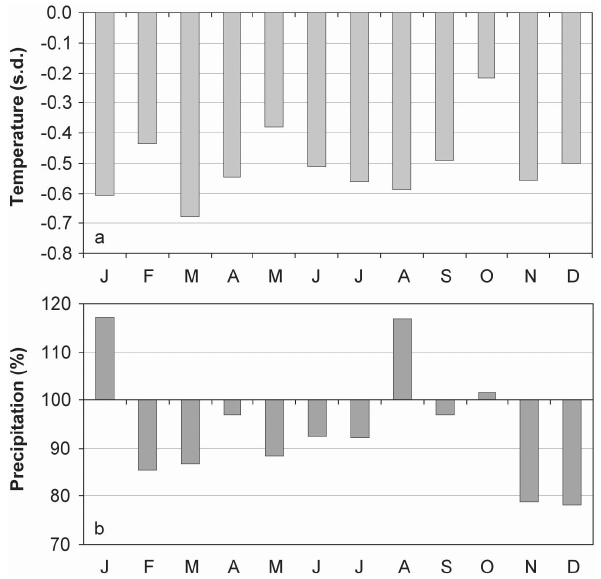
Fig. 6. Differences in mean air temperature – (a) in multiples of standard deviation (s.d.) of the 1961–2000 period – and in precip- itation totals – (b) in % of totals in the 1961–2000 period – for the homogeneous Brno series in the 1816–1855 period with respect to the 1961–2000 reference